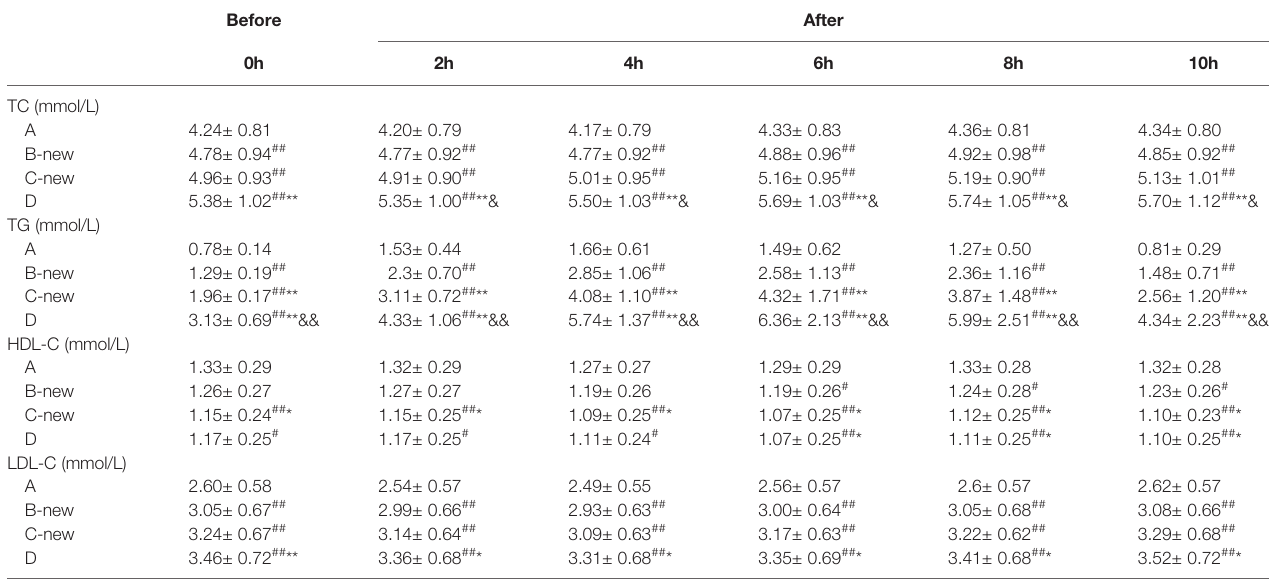
TABLE 4 | Plasma lipids concentrations at different time during OFTT of groups with different FTG. Before